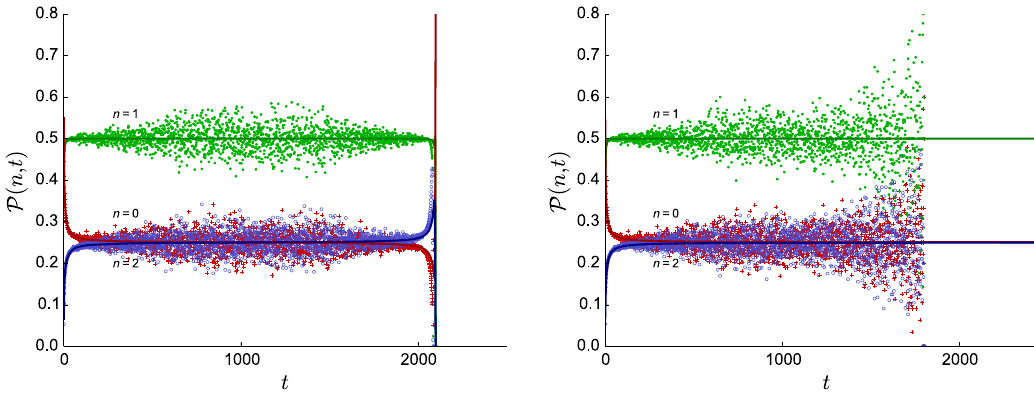
FIG. 7. Evolution of the branching distribution P ð n; t Þ below (left) and above (right) the critical point for k ¼ 3 . Solid green, red, and blue curves are theoretical curves from Eq. (6) for n ¼ 1 ; 0 , and 2, respectively, as labeled, for h q i ¼ 3 . 3509 (left) and h q i ¼ 3 . 350 92 (right). Green points, red crosses, and blue circles represent results of simulation for n ¼ 1 ; 0 , and 2, respectively, in an Erd ő s-Rényi network of 10 8 nodes, at h q i ¼ 3 . 3511 (left) and 3.351 11 (right), being just below and just above the critical mean degree for that network.